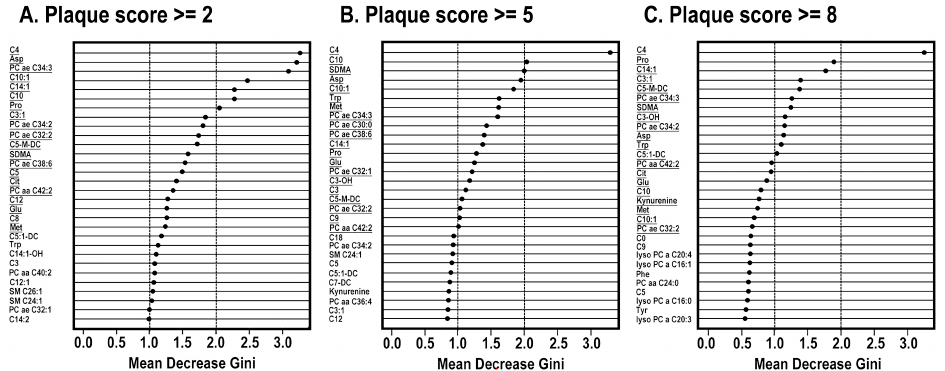
Figure 3. Random Forest study of normal controls (normal) and carotid artery stenosis (CAS) patients with plaque score ≥ 2, ≥ 5 and ≥ 8.